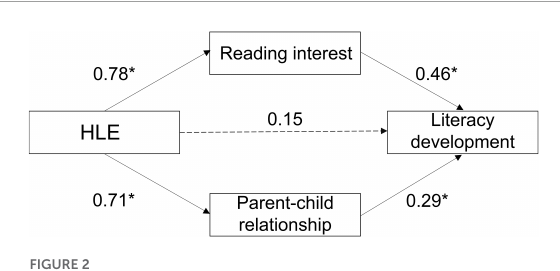
FIGURE2 Testing the model of children with hearing loss for the mediating effect of reading interest and parent-child relationship on the interaction between HLE and literacy development. * p < 0 .